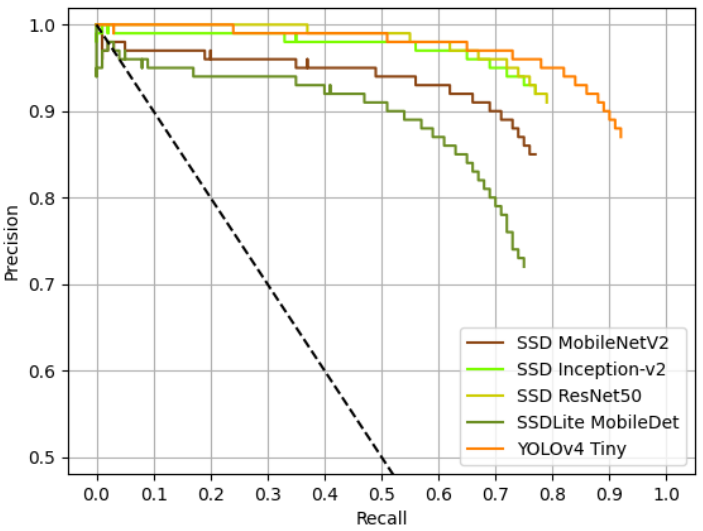
Figure 4. Precision × Recall curves of all models for a 0% confidence level. The dashed black curve represents the linear interpolation between 1.0 Precision and 1.0